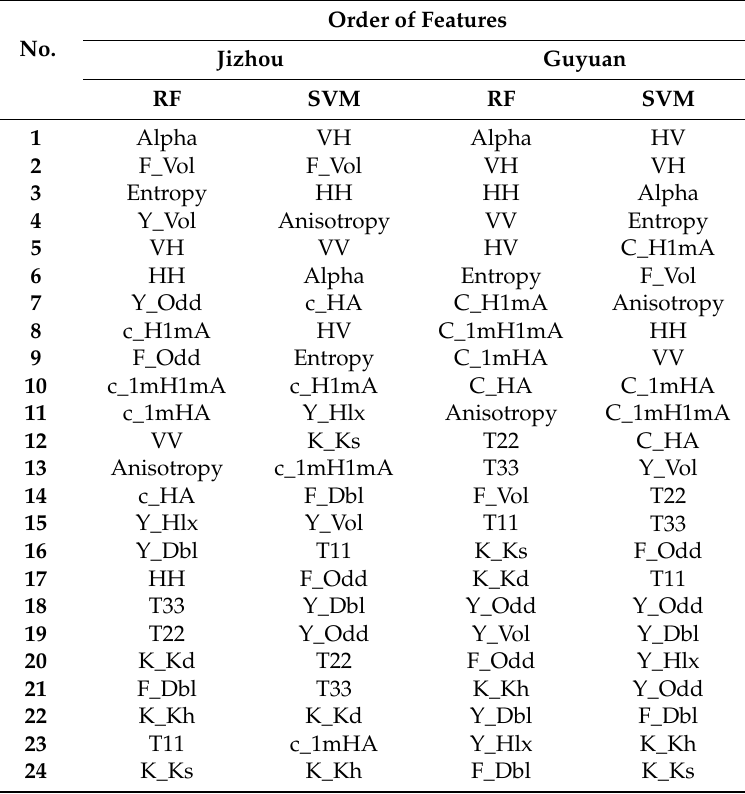
Table 9. The order of the features selected by RF and SVM in two study areas.